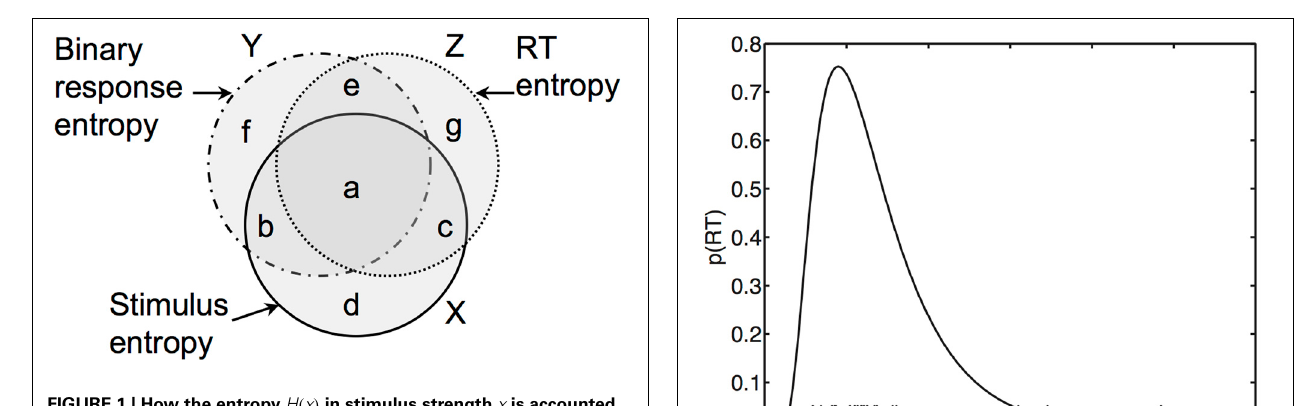
FIGURE 1 | How the entropy H ( x ) in stimulus strength x is accounted for by the entropy H ( τ ) in RT ( τ ) and entropy H ( P ) in the probability P of a particular binary response r . The entropies of x , P , and τ are represented by the discs X , Y , and Z , respectively. The mutual information between x and P is I ( x , P ) = ( a + b ) , and the mutual information between x and τ is I ( x , τ ) = ( a + c ) .